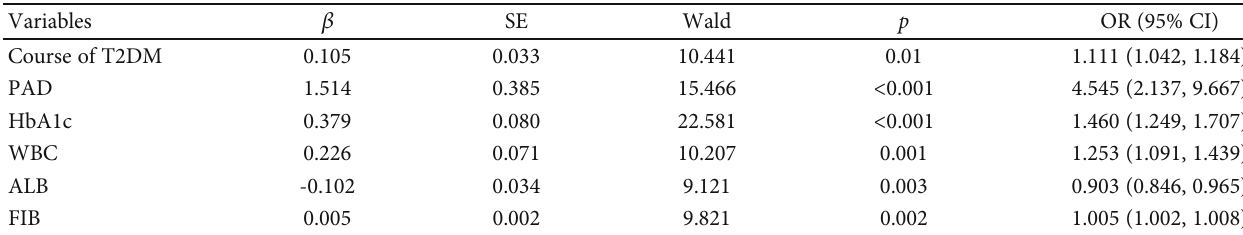
Table 2: Risk and protective factors of amputation in patients with diabetic foot